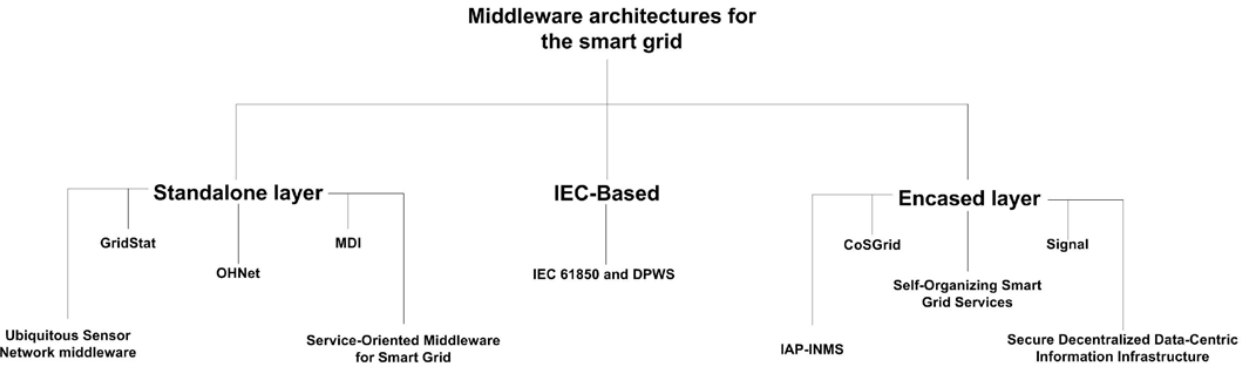
Figure 11. Taxonomy on middleware architectures for Smart Grids.